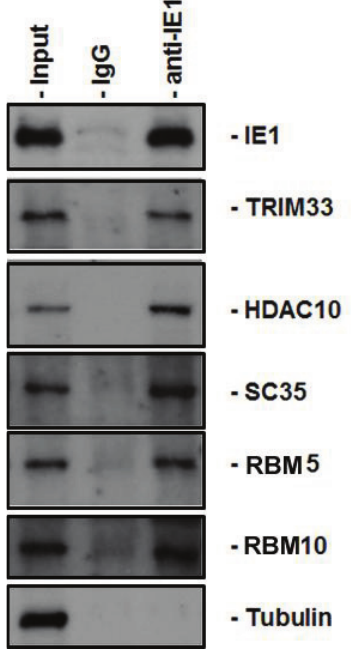
Figure 2. Validation of some IE1 PPIs by coIP. The nuclear extract from the IE1-producing cell line was prepared and incubated with anti-IE1 antibody followed by incubation with secondary bound beads. The pulled-down complexes were examined by Western blot using antibodies against the protein, as indicated on the right hand